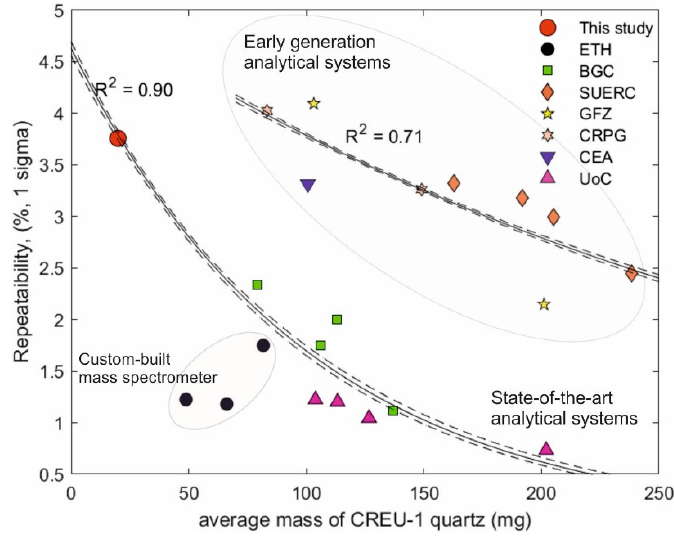
Figure 9. Repeatability of CREU-1 quartz measurements with respect to analysed amounts from a number of different laboratories worldwide. Data from Refs. [5,24,25] were split into groups by masses within 10 mg of material. The only exception was CPRG, which were significantly under dispersed. Data show that beside analysed mass (e.g., signal size of 21 Ne) the analytical system is a key factor in data quality. Data from early generation analytical systems (SUERC, CRPG, GFZ, CEA) grouped together and showed the lowest performance at a given mass. Data emerged from state-of-the-art analytical systems including modern electronics, and a high degree of automation (see text) (ARGUS VI in SUERC of this study, BGC and UoC) characterises another group, showing an excellent correlation (n = 9, 39 individual measurements) between the analysed amount of CREU-1 quartz and of 21 Ne * . Only the custom-built mass spectrometer (ETH) showed a better performance. We conclude that SUERC’s ARGUS VI mass spectrometer analysed 19.9 mg of CREU-1 quartz performs as expected. Apart from three laboratories globally (ETH, BGC and UoC), all laboratories would require the analysis of 5 times or more material to reach the repeatability of this study. ETH (Switzerland), BGC (USA), SUERC (Scotland), GFZ (Germany), CRPG (France): CEA: China Earthquake Administration (PR China), UoC: University of Cologne (Germany). 1 sigma errors on masses are smaller than symbols. Curve errors are 1